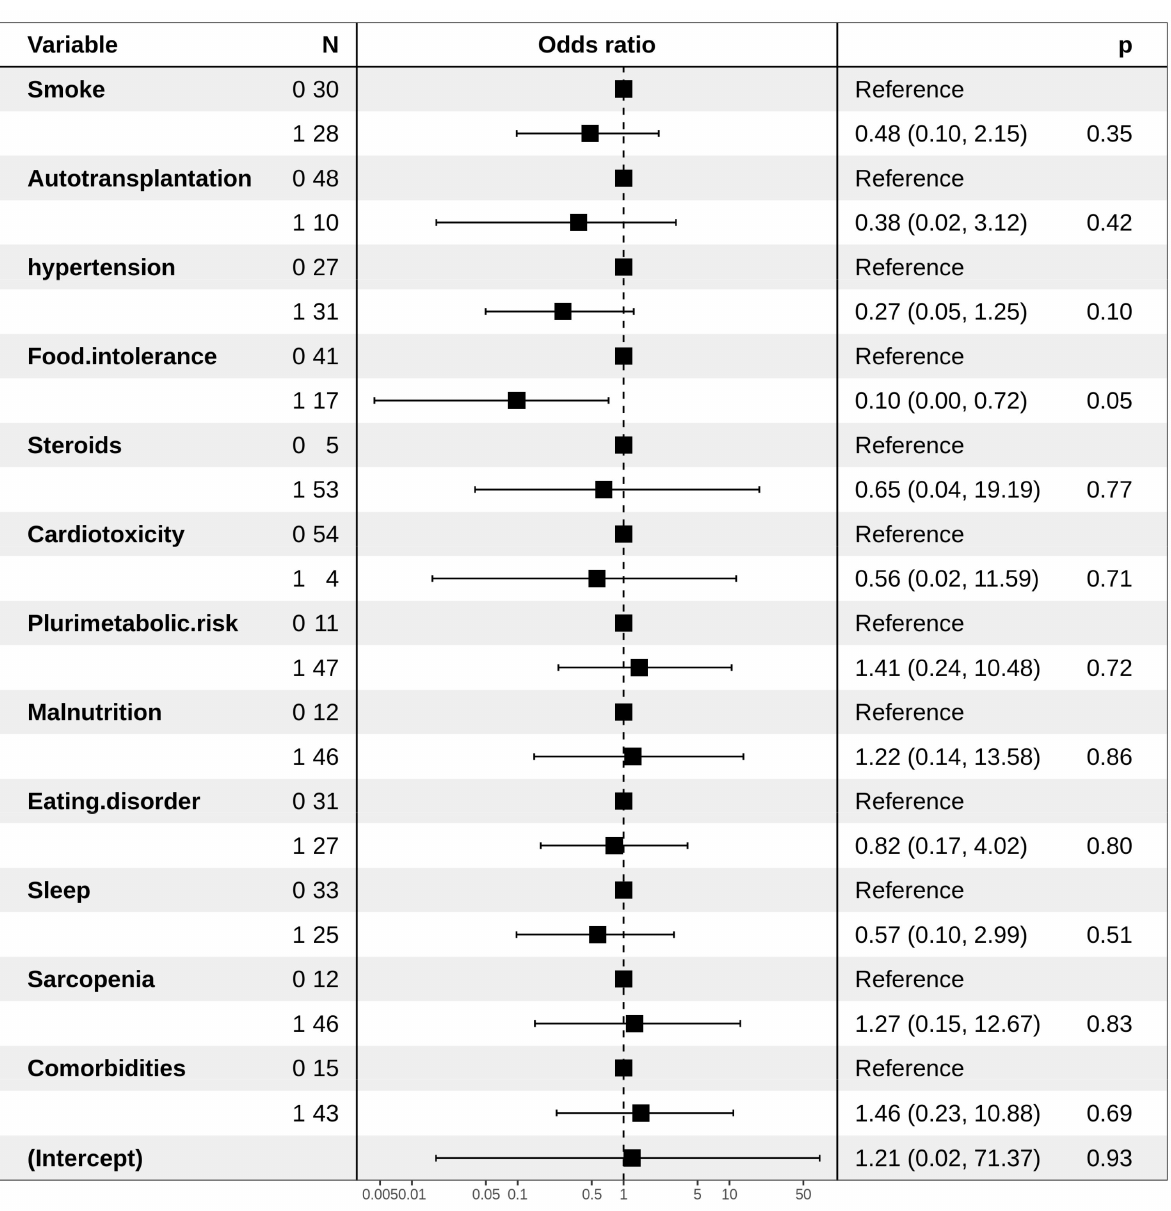
Figure 2. Forest plot representing multivariate logistic regression for dyslipidemia